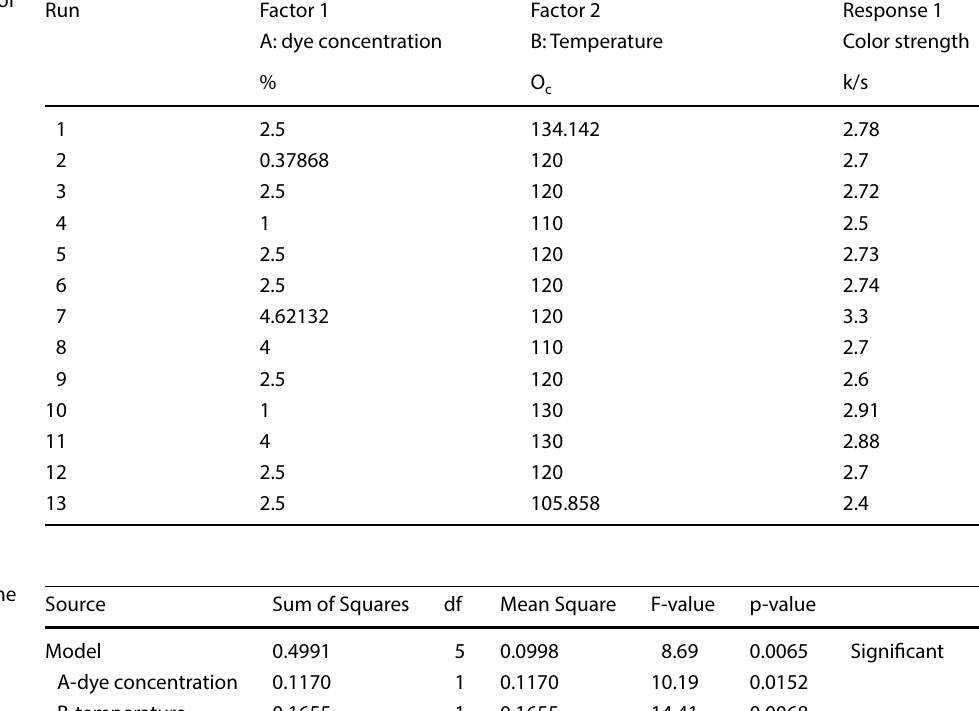
Table 3 Experimental result of the dyeing process